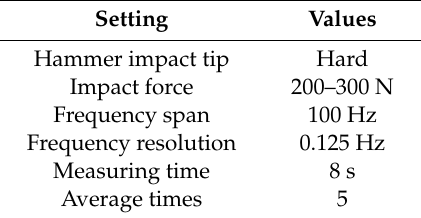
Table 4. Parameter settings in the modal analysis system.